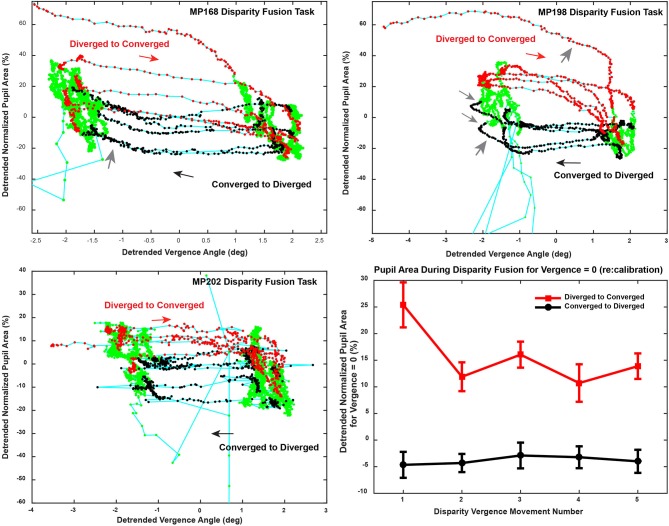
Trajectory of the vergence angle and pupil area during the binocular fusion step task is shown in the upper and lower left panels. The upper right (MP198) and lower left (MP202) panels area are plotted from data shown in in Figure 2A. Successive sample points (100 Hz sample rate) are plotted in green, with the dots indicating the convergent (red dots) and divergent (black dots) disparity-driven responses. The directions of the trajectories between fixations is indicated with arrows. Note that response patterns include periods when there are (1) almost exclusively vergence eye movements (horizontally oriented segments), (2) almost exclusively pupil area changes (vertically oriented segments), (3) combinations that reflect a near response pattern (pupil constriction with convergence and dilation with divergence, larger gray arrows) and (3) a pattern that is opposite the near response (smaller gray arrows). The lower right panel shows the average pupil area (normalized to light reflex range) at zero vergence for successive increments) to show the stability across repeated binocular disparity steps.